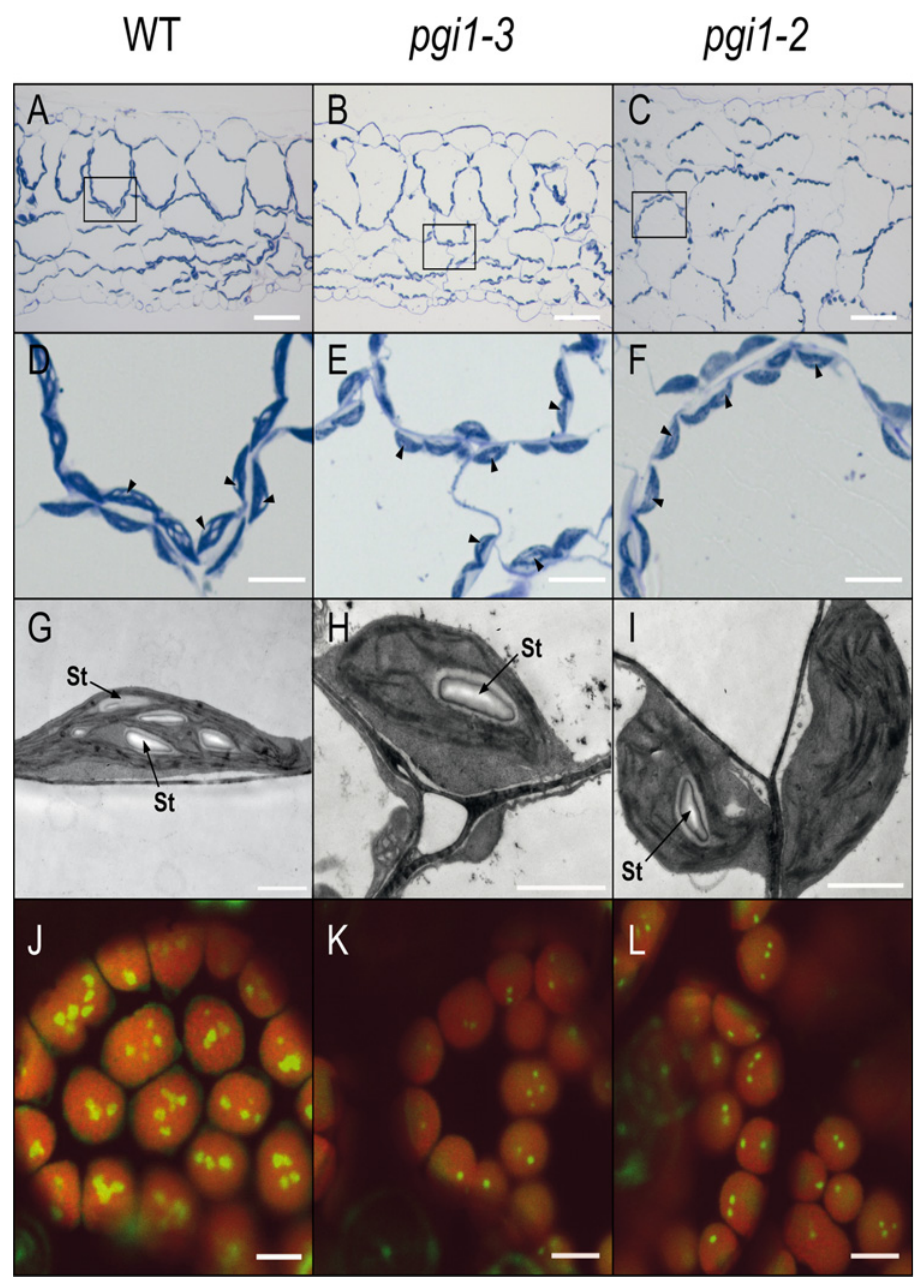
Fig 5. Microscopic analysis of starch granules in WT (L er ), pgi1 – 2 and pgi1 – 3 source leaves. (A-C) Light microscopy of toluidine stained leaf sections (Bar = 50 μ m). (D-F) Magnification of mesophyll sections indicated in A-C (Bar = 10 μ m). (G-I) TEM of WT, pgi1 – 2 and pgi1 – 3 leaves. Bar = 2 μ m. (J-L) CFM of leaves of GBSS-GFP expressing WT, pgi1 – 2 and pgi1 – 3 leaves. Bar = 5 μ m. Plants were cultured on soil under LD conditions and source leaves harvested from 30 DAG plants after 12 h of illumination. In D-F, arrows indicate the position of starch granules. St: starch.